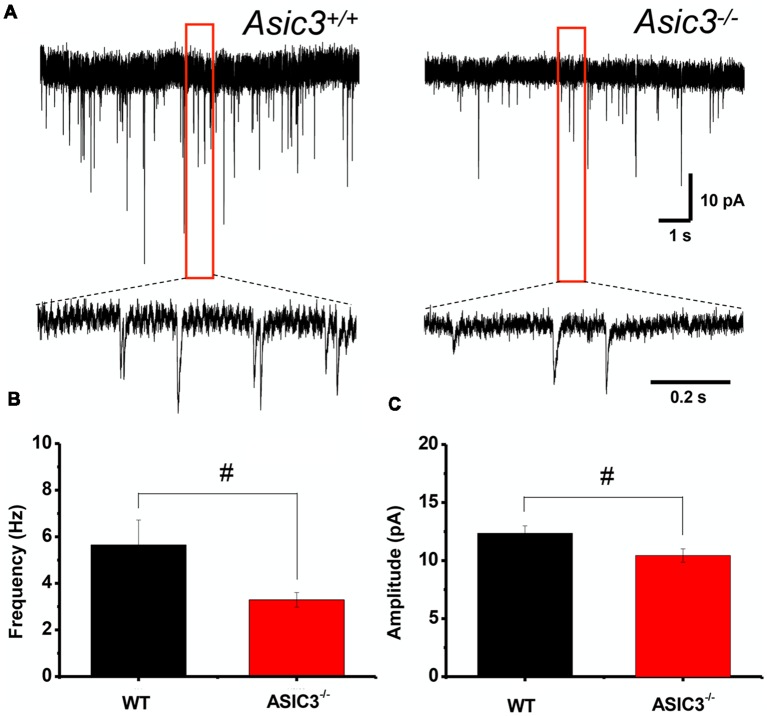
Reduced corticostriatal synaptic transmission in Asic3−/− medium spiny neurons (MSNs). (A) Representative traces of mEPSC from Asic3+/+ and Asic3−/− MSNs recorded with whole-cell voltage clamp. Reduced mEPSC: (B) the frequency and (C) the amplitude of mEPSC were reduced in Asic3−/− MSNs as compared with Asic3+/+ MSNs (frequency: t = 2.27013, df = 16, p = 0.01869; amplitude t = 2.16085, df = 16, p = 0.02311; N = 8–10 mice per group; #p < 0.05 vs. Asic3+/+). Data are mean ± SEM. Data analyzed by two-tailed unpaired t-test.